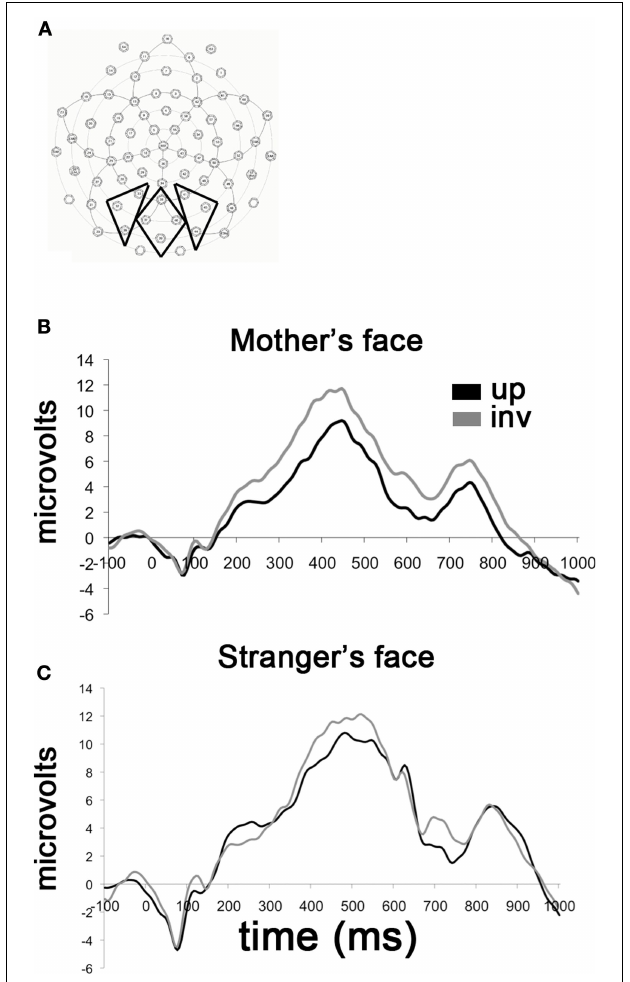
FIGURE 2 | Responses to upright and inverted faces as a function of personal familiarity. (A) The P400 waveform depicted here represents averaged activity over 10 occipital electrodes included in the analysis. These 10 electrodes were grouped into three distinct regions for statistical analysis of regional effects. (B) Grand-averaged waveforms obtained for mother’s face upright and mother’s face inverted. (C) Grand-averaged waveforms obtained for a stranger’s face upright and inverted. Note the absence of a differential response to upright and inverted faces in the “unfamiliar face” group.